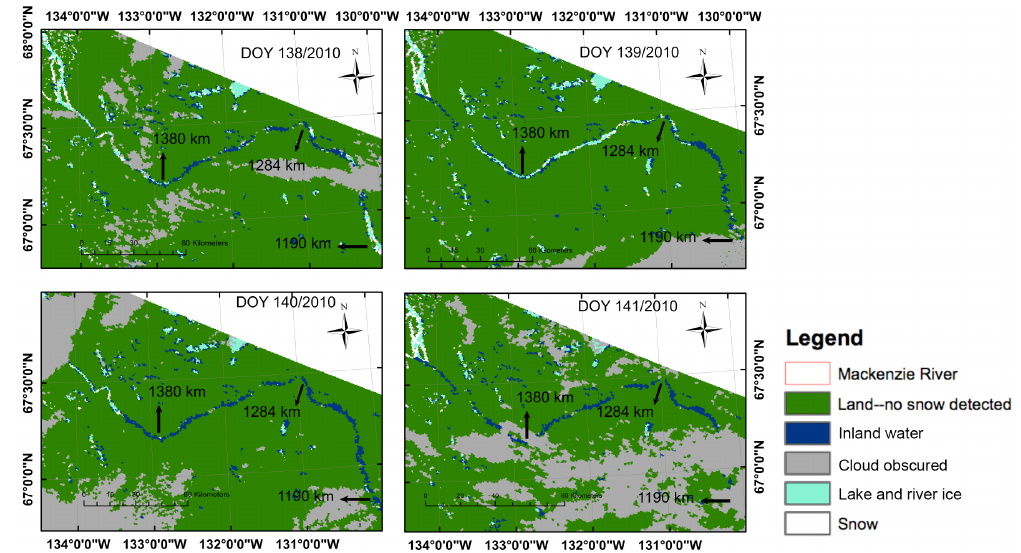
Figure 11. Ice flushing event recorded in 2010 between DOYs 138 and 141. Here, on DOY 141, the ice movement is last recorded after exiting into the Mackenzie Delta.